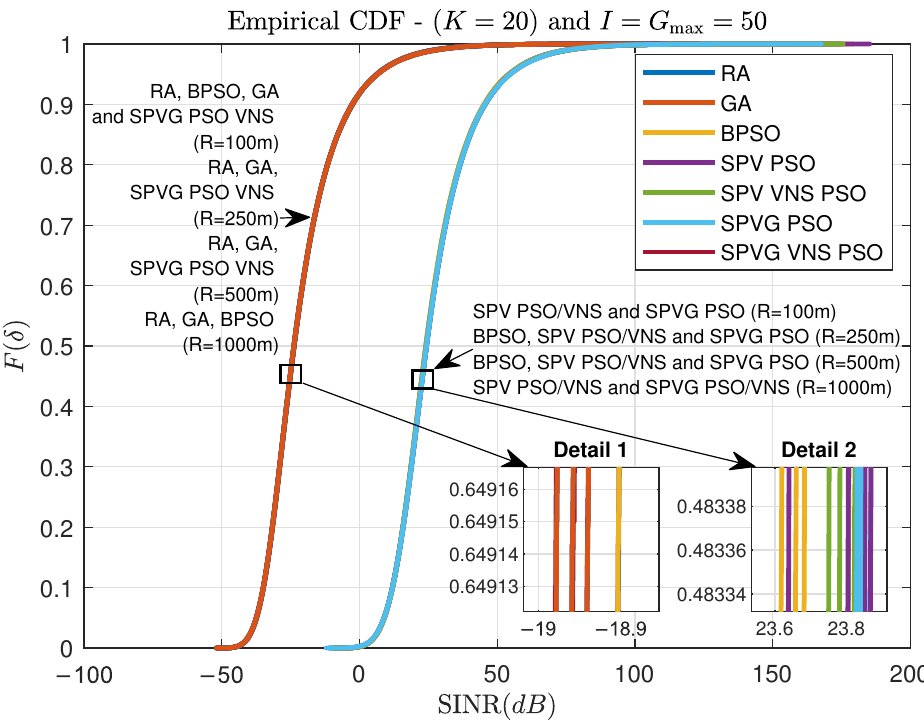
Figure 8. Empirical CDF for different cell sizes with K = 20 users, G max = 50 generations and I = 50 iterations.